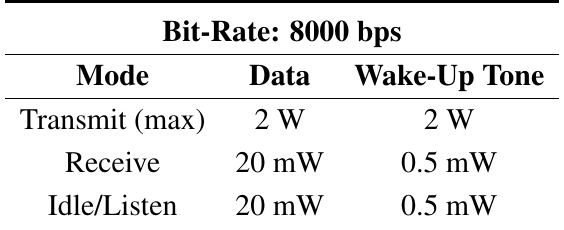
Table 2. Acoustic modem